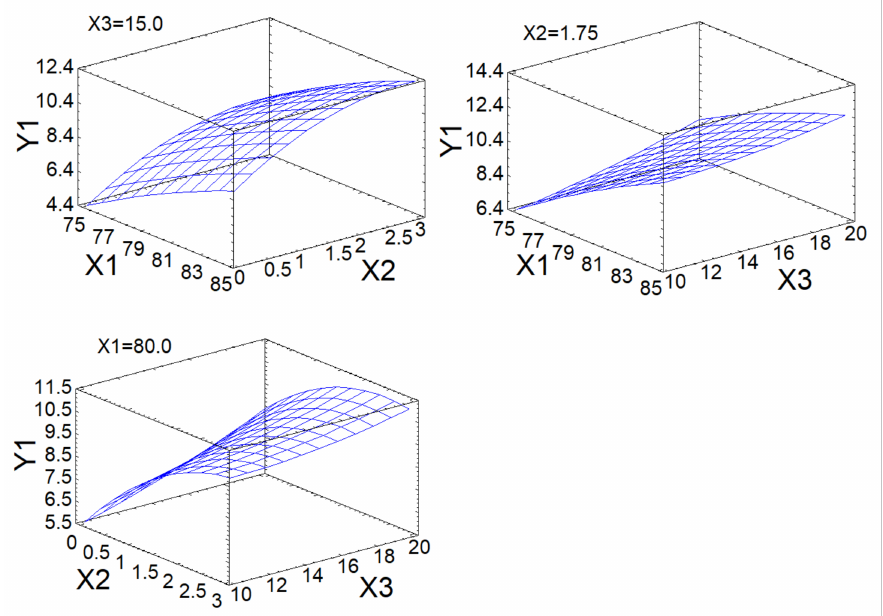
Figure 4. Responsesurfaceoftheoutputparametersunderdifferenteffectsoftheexperimental